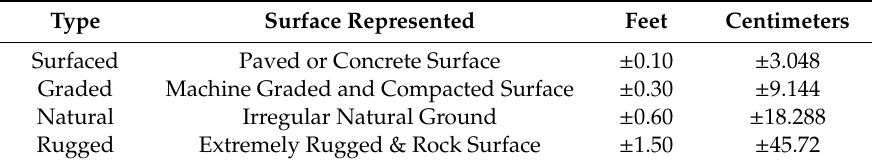
Table 1. Idaho Transportation Department Highway Construction